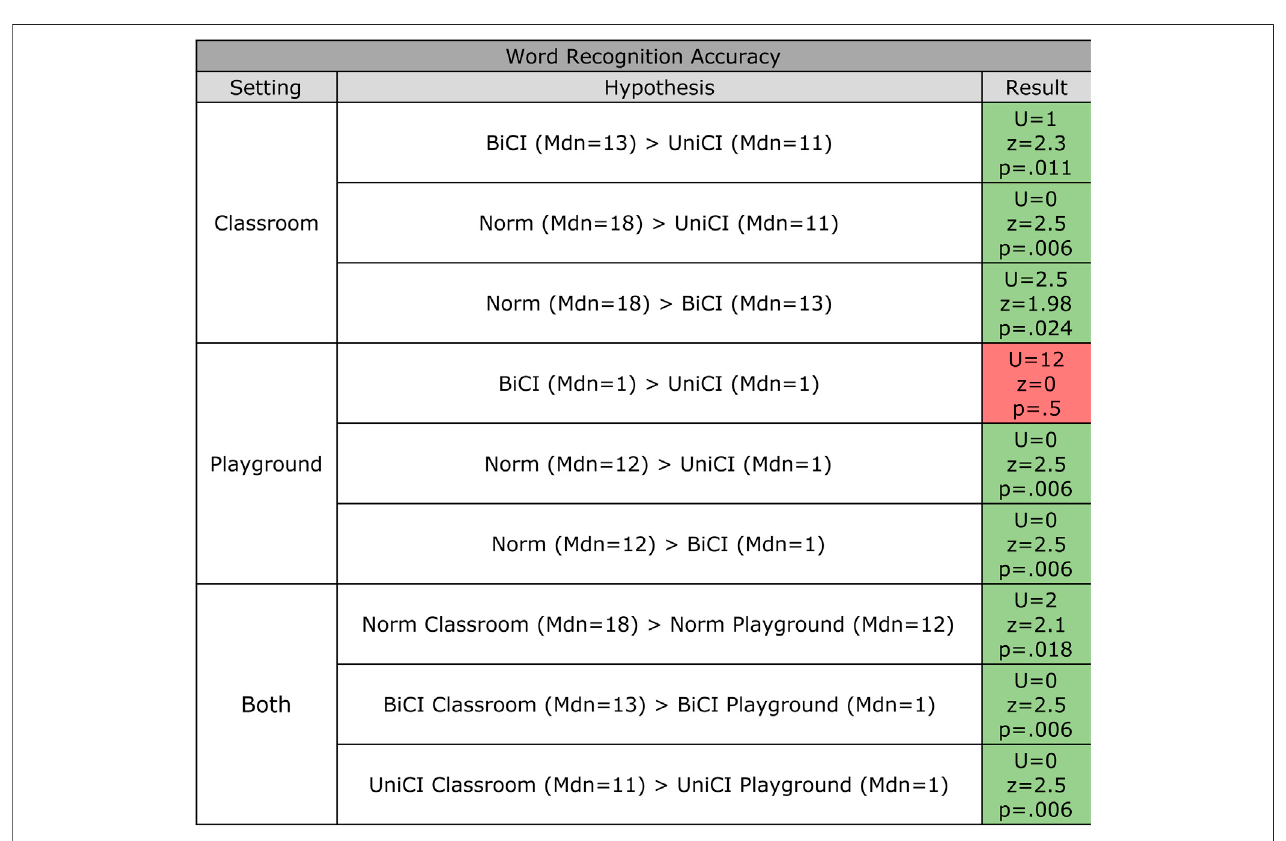
FIGURE 13 | Mann-Whitney U test results for each alternative hypothesis for the word recognition accuracy. The critical value of U at p¡.05 is 4. UniCI, BiCI, and Norm denote simulated unilateral CI, bilateral CI, normal hearing, respectively. Green and red colors indicate the hypothesis is accepted and rejected, respectively.